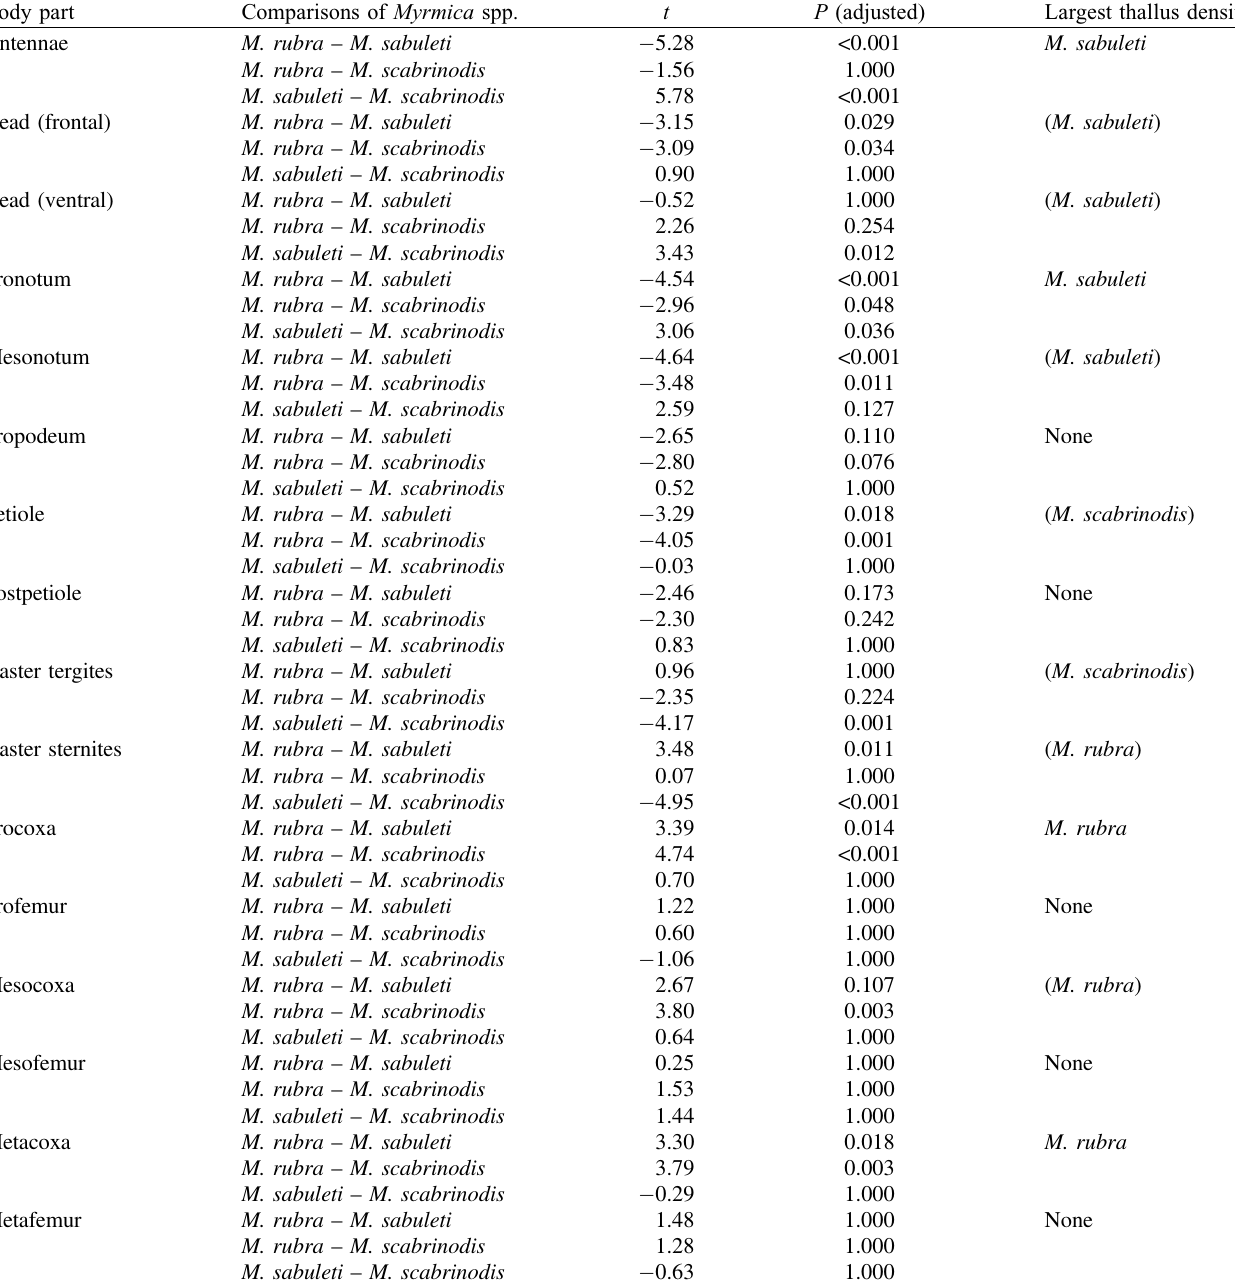
Table 5. Results of Conover-Iman tests on the species differences of body parts in absolute thallus density. The column “ Largest thallus density ” shows which host species had highest number of thalli on a given body part; species names in parentheses indicate that the difference between the speci fi ed species and one of the other two species is not signi fi cant; “ none ” means that the three species did not differ signi fi cantly from one